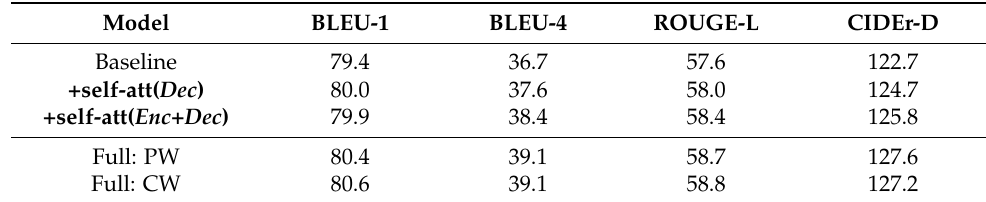
Table 5. Ablation studies for our method. All results are obtained after CIDEr-D score